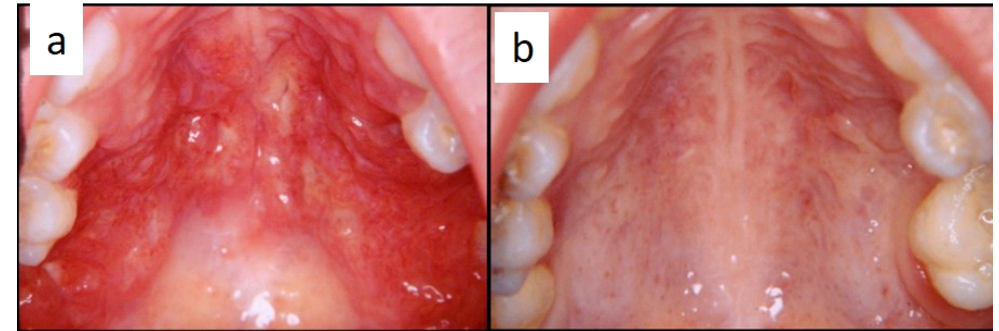
Figure 2. ( a – d ): Primary periodontal manifestations of LCH in a 5-year-old male: multiple osteolytic lesions in the mandible and in the maxilla ( a ) associated with gingival overgrowth and inflammation ( b ) and to painful ulceration of the gingiva with radicular exposure, bone loss ( c ) and tooth mobility with incomplete radicular formation due to the dental follicle involvement ( d ).